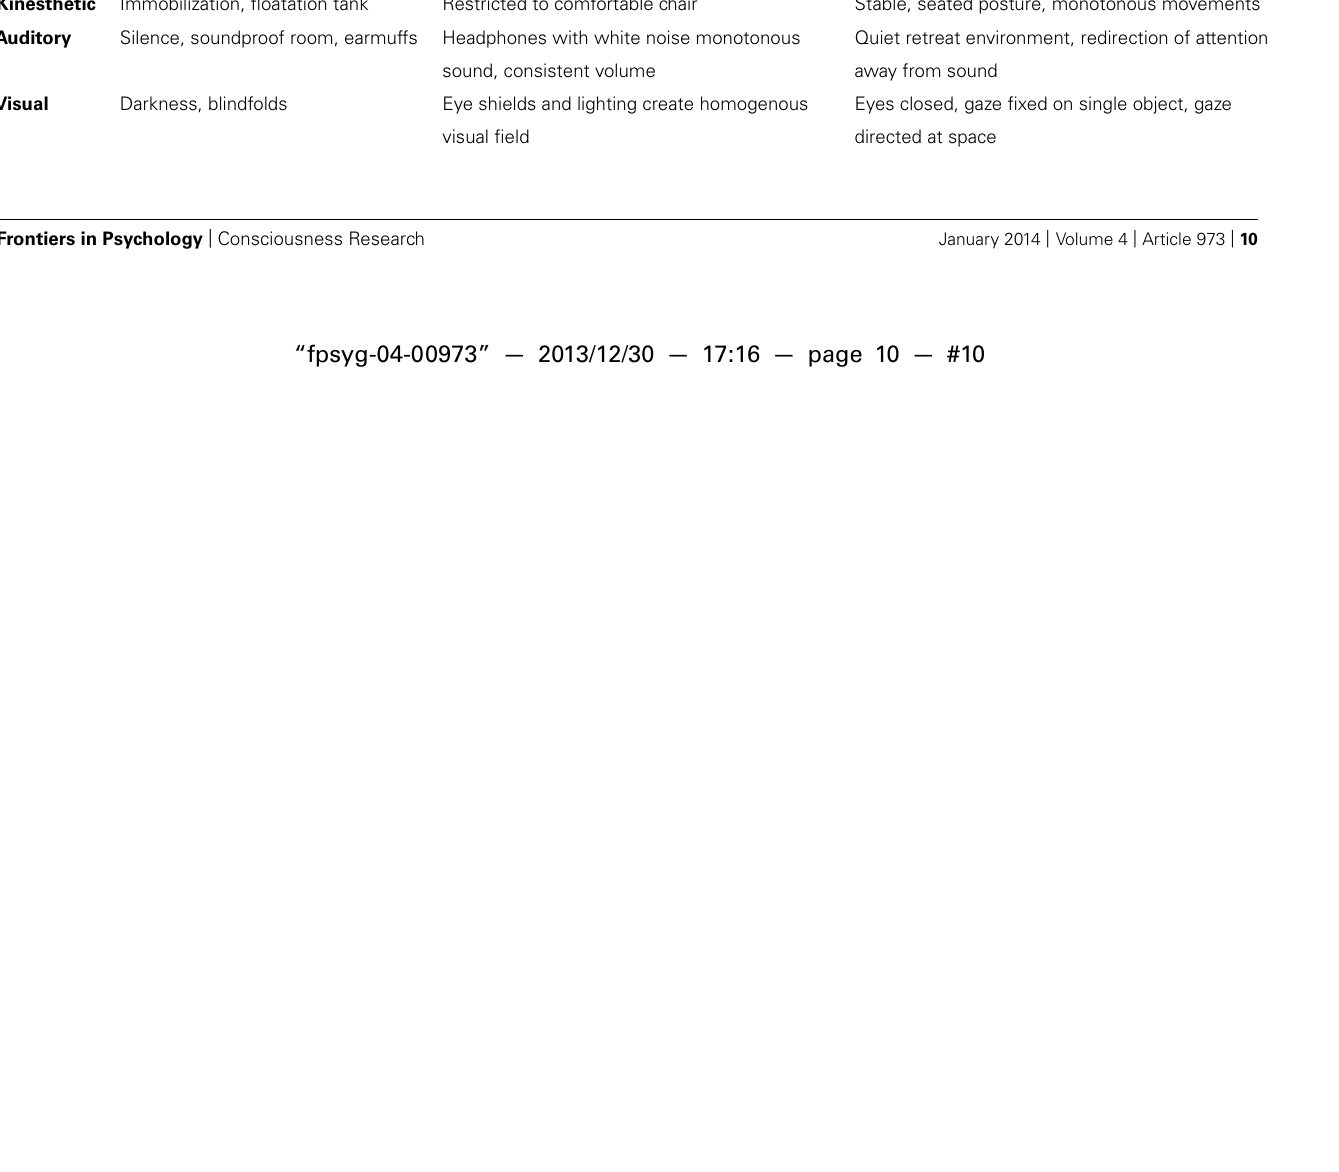
Table 3 | Comparison of sensory deprivation, perceptual isolation, and meditation. Sensory deprivation Perceptual isolation Meditation Social Isolation from human interaction Isolation from human interaction and Retreat environment temporary social isolation and communication communication Kinesthetic Immobilization, floatation tank Restricted to comfortable chair Stable, seated posture, monotonous movements Auditory